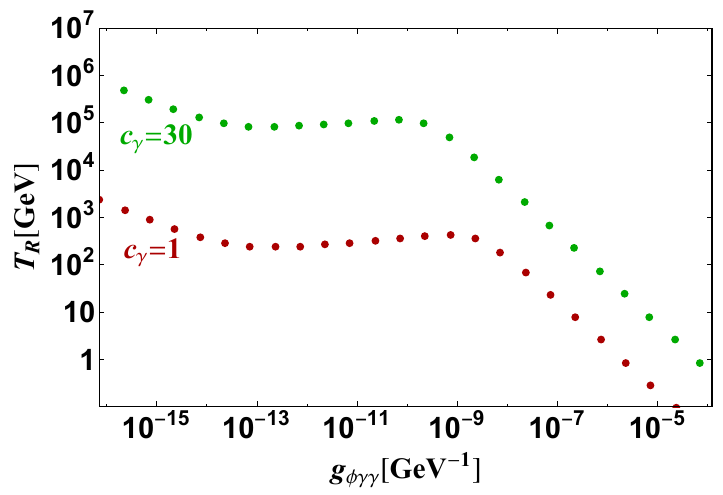
Figure 4 . The reheating temperature of the ALP in(cid:13)ation ( n = 2) with coupling to photons is shown as a function of g (cid:30)(cid:13)(cid:13) . Here we show the two cases with c (cid:13) = 30 ( c Y = 18 and c 2 = 24) [green] and with c (cid:13) = 1 ( c Y = 1 and c 2 = 0) [red]. We take C = C 0 = C 00 = 1 for